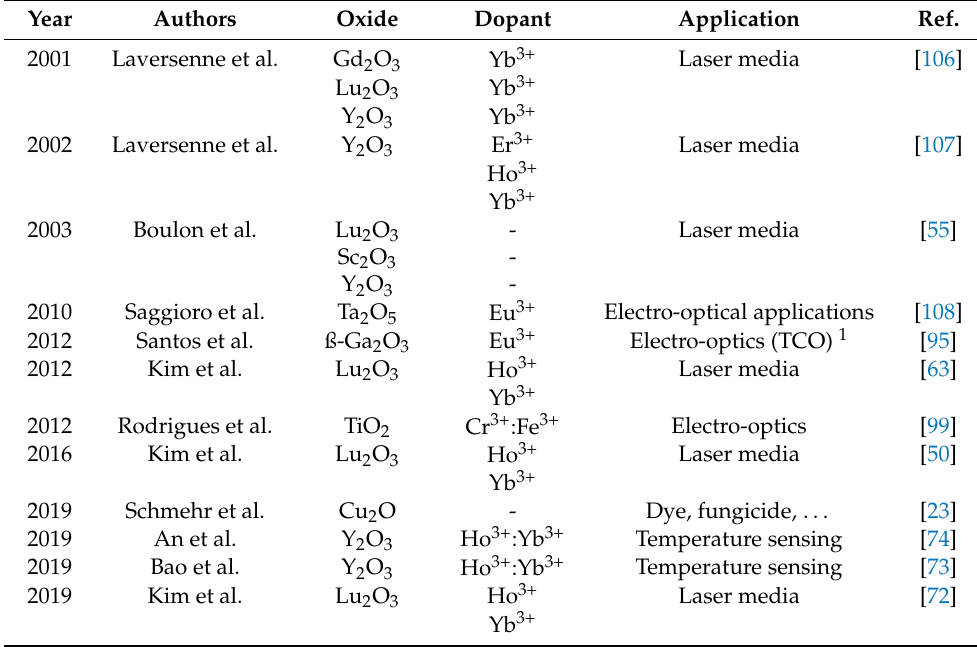
Table 4. Crystalline fibers of sesquioxides and other binary oxides produced by LFZ since 1999